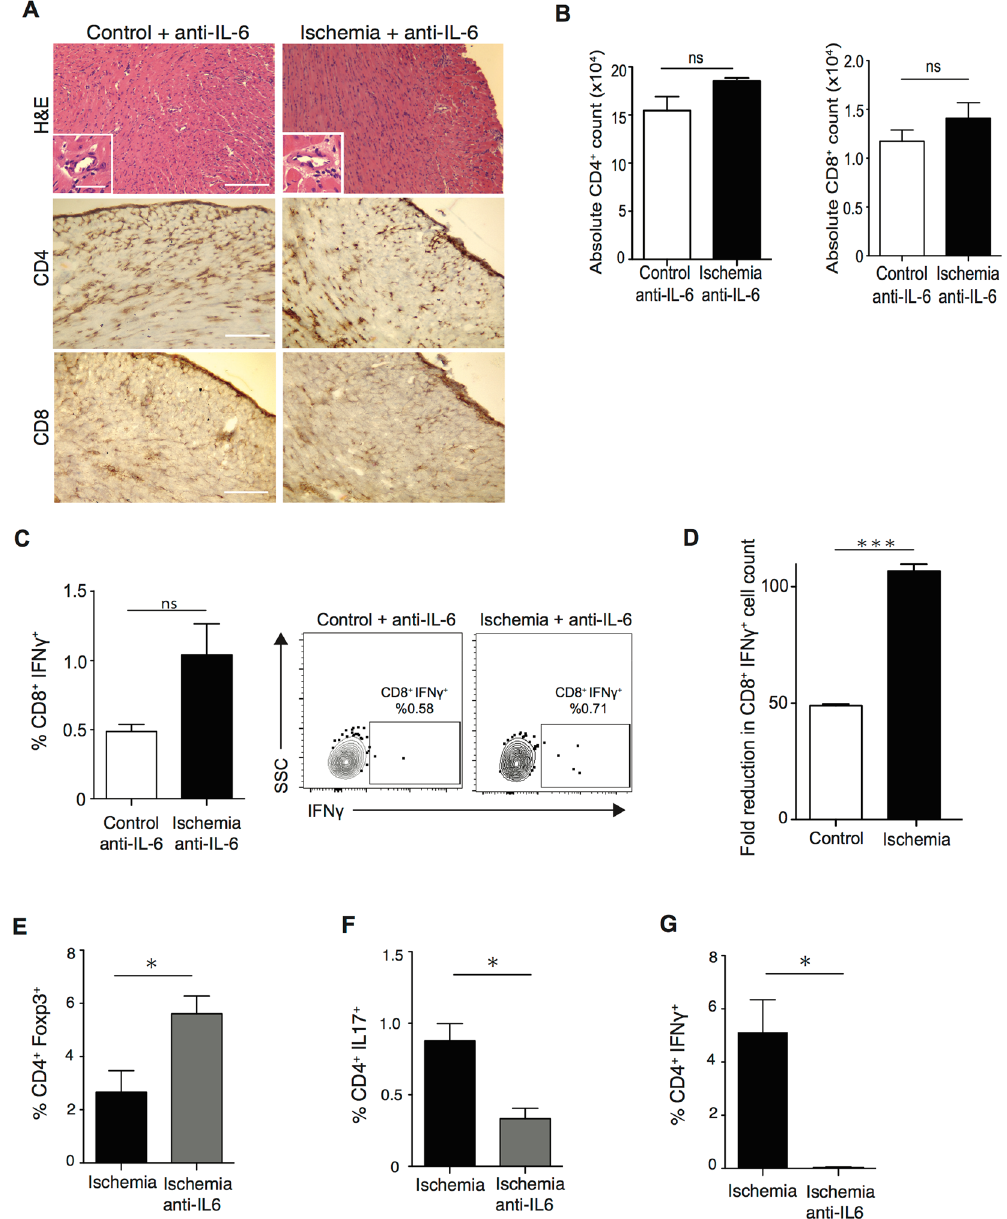
Figure 5. Antagonizing IL-6 markedly reduces alloreactive T cell infiltration following IRI. ( A ) Control and ischemic OVA hearts were transplanted into OTII recipients. Recipients were treated with anti-IL-6 and heart grafts were harvested at day 6. No difference was noted in cell infiltration, CD4 + and CD8 + T cell infiltration between control and ischemic grafts. (Scale bar 100 μ m for H&E, CD4 and CD8 stain. Inset scale bar 30 μ m). ( B ) Absolute number of CD4 + and CD8 + T cell by flow cytometry analysis were similar in both groups (15.4 × 10 4 ± 1.4 × 10 4 vs. 18.5 × 10 4 ± 0.1 × 10 4 , p = 0.1 for CD4 + T cells and 1.1 × 10 4 ± 0.1 × 10 4 vs. 1.4 × 10 4 ± 0.1 × 10 4 , p = 0.29 for CD8 + T cells, respectively, n = 3/group). ( C ) Minimal CD8 + IFN γ + T cell infiltration was observed and no statistical difference was seen between ischemic and control allografts (0.48 ± 0.05% vs. 1.04 ± 0.2%, p = 0.05, n = 3/group). Representative flow plots, gated on CD8 + T cells. ( D ) Marked reduction in graft infiltration by CD8 + IFN γ + T cells seen following anti-IL-6, with greater effect in ischemic organs. (Fold reduction in CD8 + IFN γ + : control vs. ischemia 49.04 ± 0.52 vs. 106.74 ± 2.97, *** p < 0.001). ( E ) Significantly higher percentage of CD4 + Foxp3 + T cells was seen in anti-IL-6 treated ischemic graft compared to untreated ischemic graft (5.61 ± 0.67% vs. 2.66 ± 0.81%, * p < 0.05, n = 3/group). ( F ) Significantly lower percentage of CD4 + IL17 + T cell was seen in anti-IL-6 treated ischemic graft compared to untreated ischemic graft (0.33 ± 0.07% vs. 0.88 ± 0.12%, * p < 0.05, n = 3/group). ( G ) Significantly lower percentage of CD4 + IFN γ + T cell was seen in anti-IL-6 treated ischemic graft compared to untreated ischemic graft (0.04 ± 0.02% vs. 5.13 ± 1.21%, * p < 0.05, n =